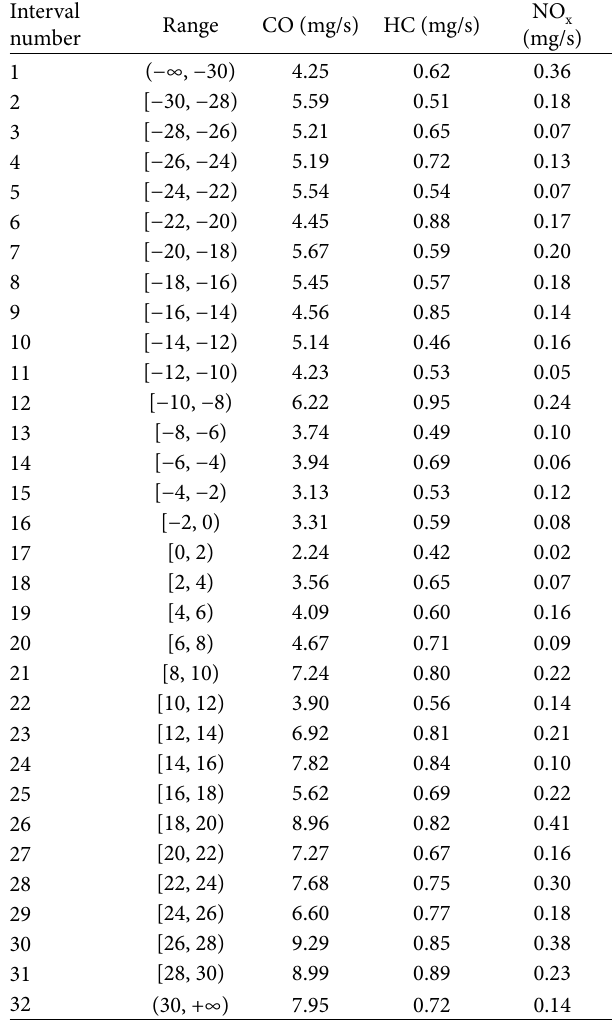
Table 2: VSP intervals and emission rates in a step of 2 kW/t.